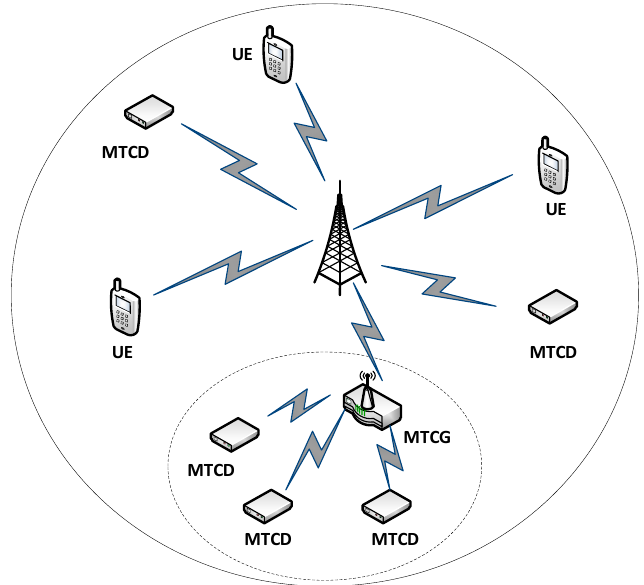
Figure 1. A coexisting HTC/MTC cellular model.